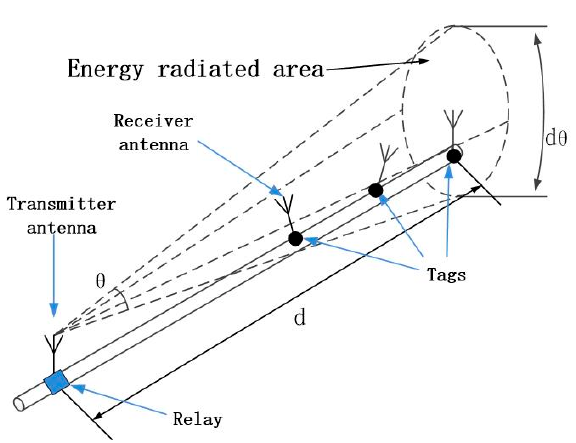
Figure 3. Basic model of wave transmission on power line.